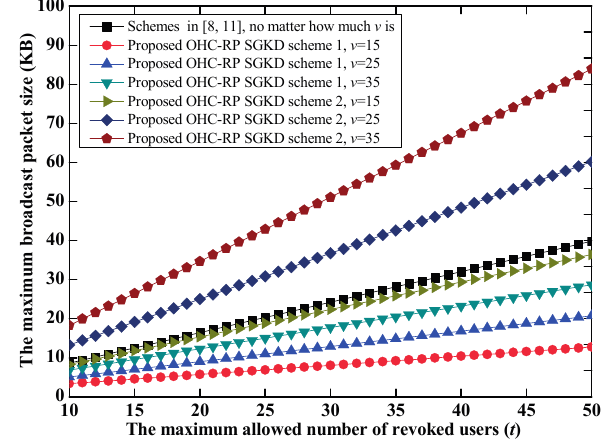
Figure 1. The comparison of the maximum broadcast packet